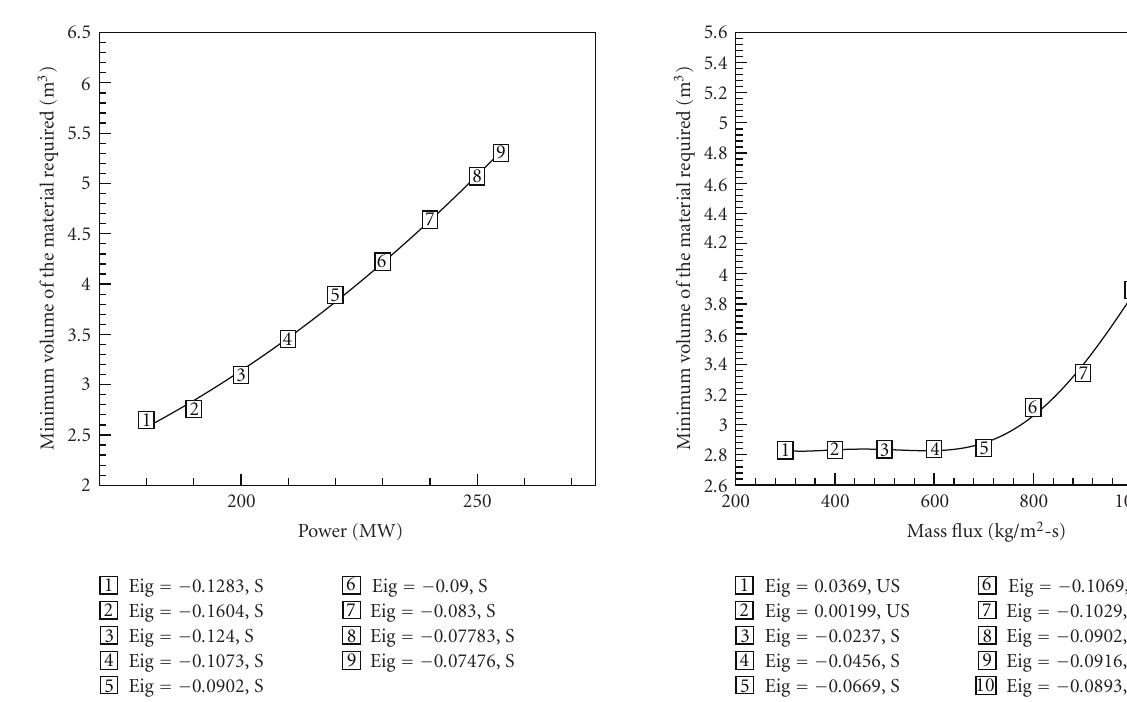
Figure 14: Variation of minimum volume of the material required with power.